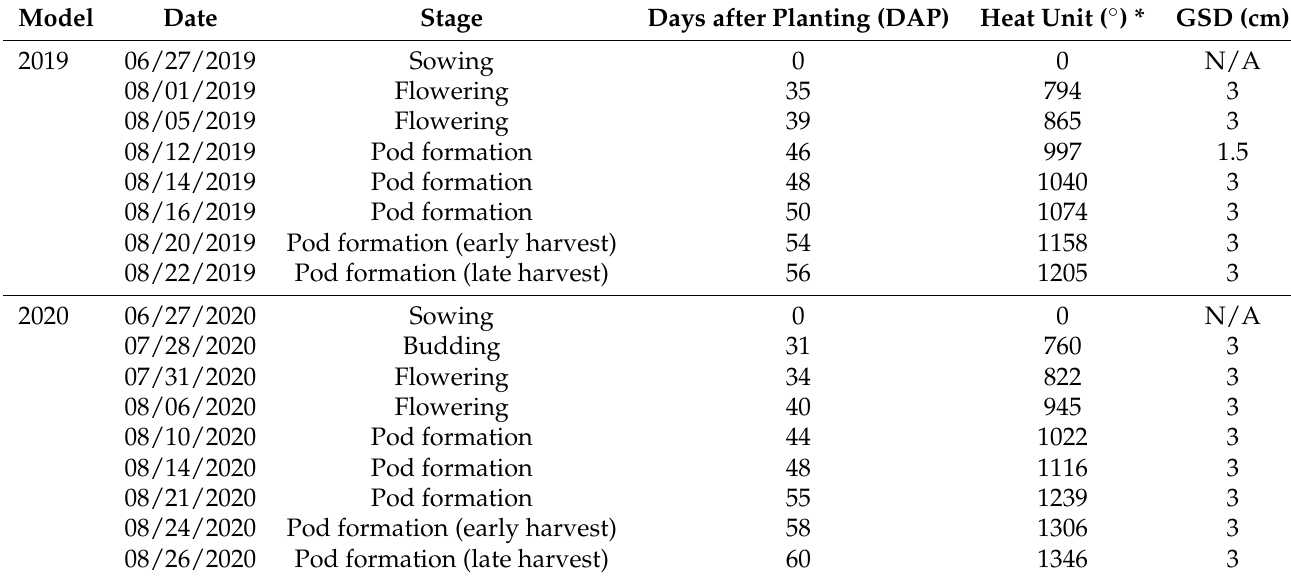
Table 1. Growth calendar of 2019 and 2020 experimental designs along with the captured ground sampling distance (GSD) of a snap bean field in Geneva, New York, USA. Please note that the first date is the sowing date and no data were collected.